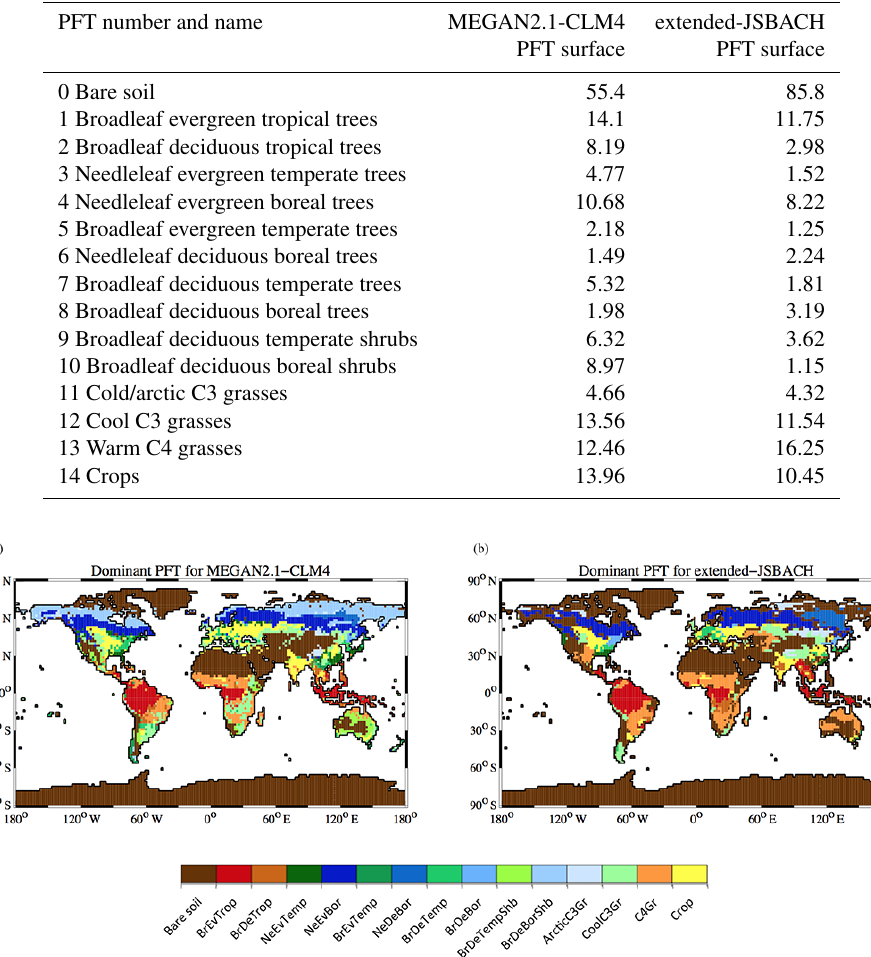
Figure 7. Distribution of dominant PFTs for the (a) MEGAN2.1-CLM4 and (b) extended-JSBACH